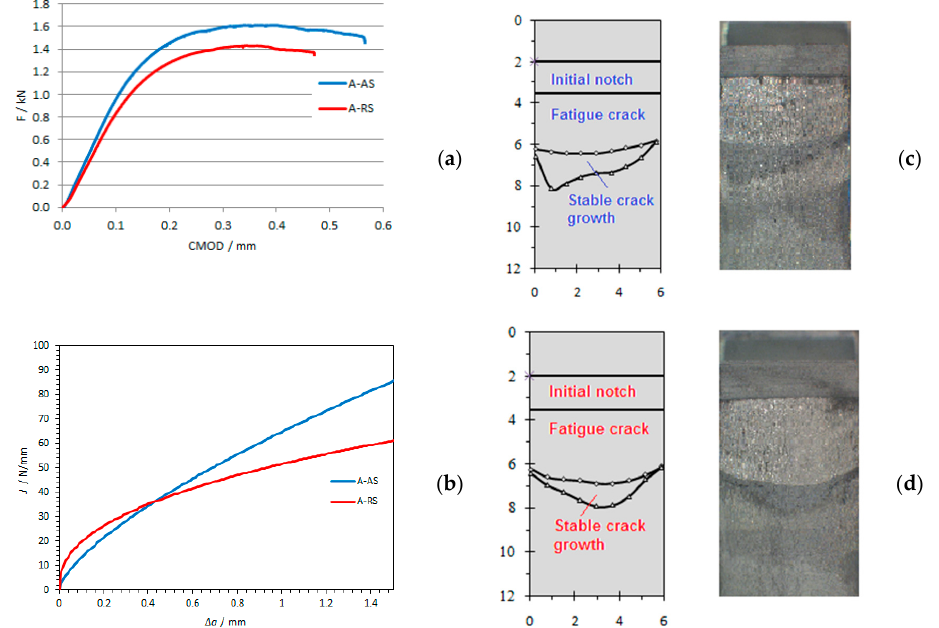
Figure 8. ( a ) Experimental data of load-displacement for specimens for welding speed v = 73 mm/min; ( b ) Comparisons of J-R curves for specimen A-AS and A-RS; ( c ) crack surfaces on advancing side (AS)for specimen A-AS; ( d ) crack surfaces on advancing side (AS)for specimen A-RS. (A-AS—specimen for welding speed 73 mm/min (A)—notch position 4 mm from center of weld on advancing side (AS); A-RS—welding speed 73 mm/min (A)—notch position 4 mm from center of weld on retreating side (RS)).